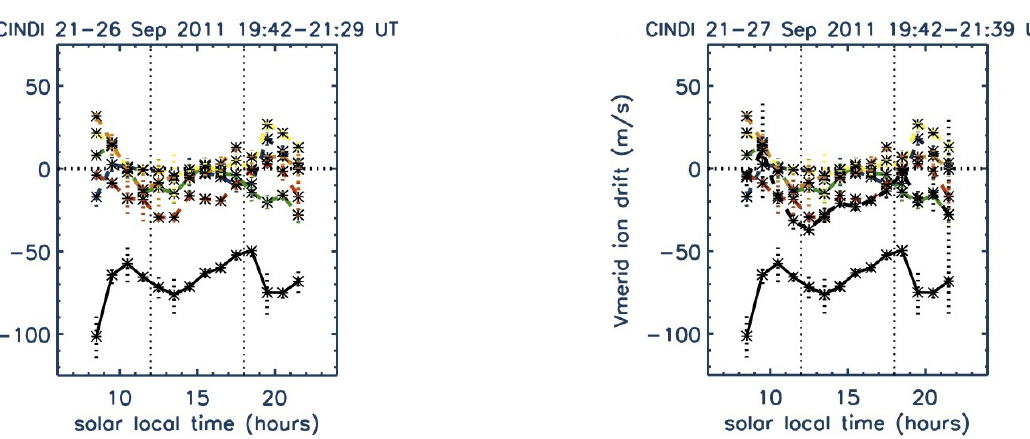
Figure 7. This figure presents the same data as in Fig. 6, but with the meridional flows from the pass on the recovery day (27 September) at the same time added in as a dashed black line. It is clear that the flows on the recovery day have returned to nearly those observed on the baseline quiet days, thus indicating that the excess downward flows seen on 26 September must be a result of the storm